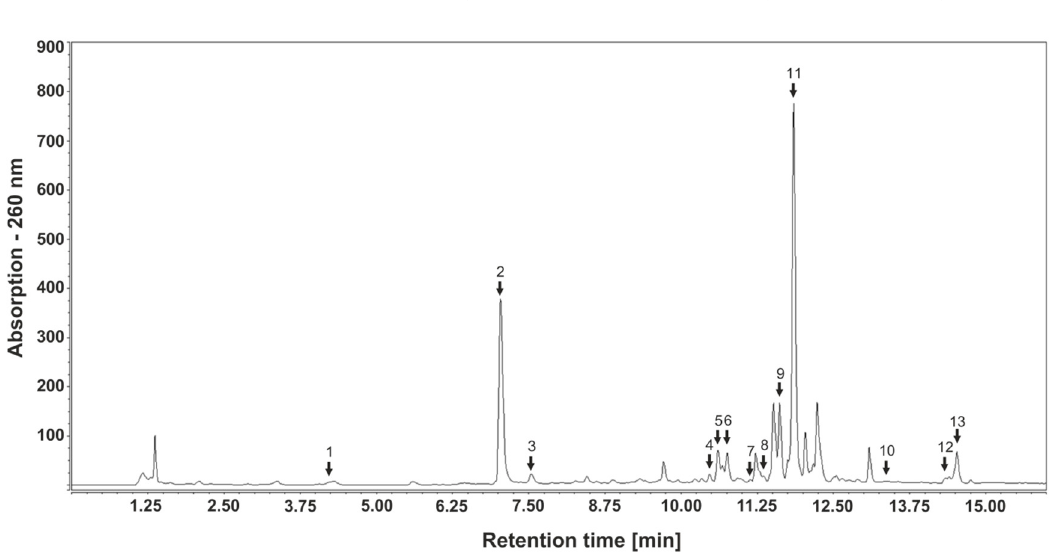
Figure 4. HPLC-diode array detector (DAD) chromatogram of home-made Bellis perennis extract recorded at 260 nm. For peak numbers, refer to Table 1. Table 1. Identification of phenolic compounds in Bellis perennis extracts using HPLC with DAD and